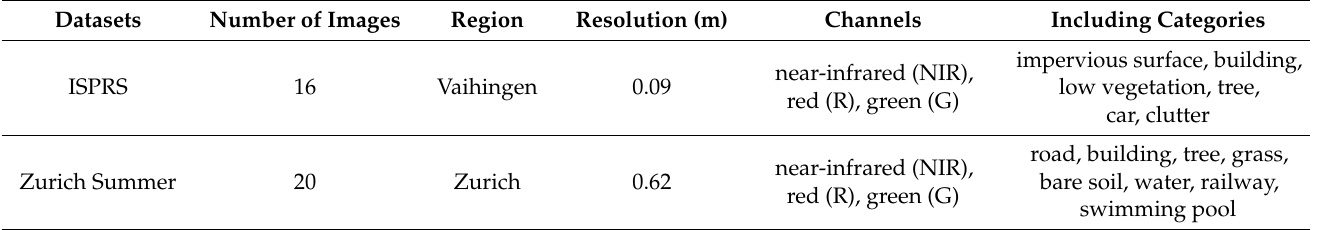
Table 1. Detailed information of remote sensing